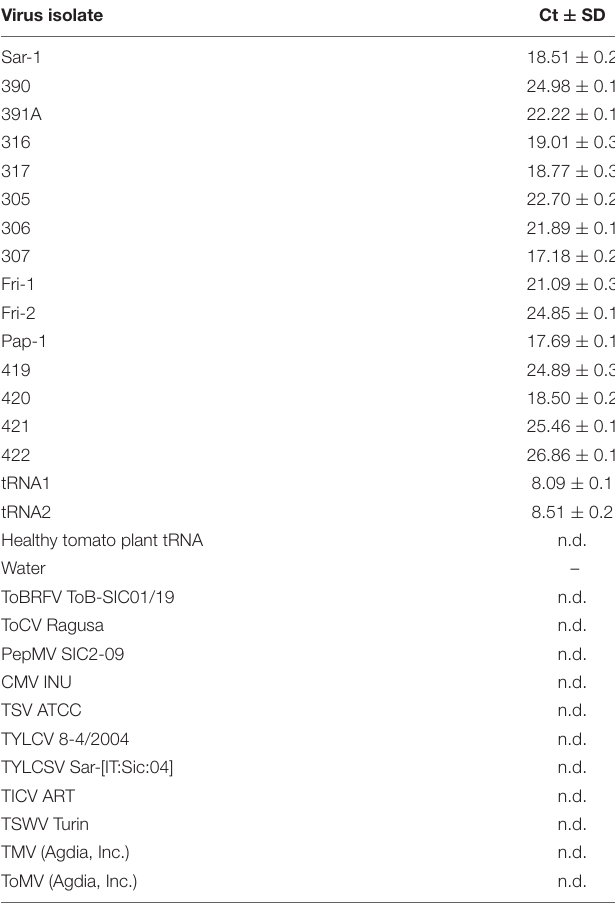
TABLE 3 | Ct values obtained by RT-qPCR assay with TaqMan probe of fifteen PMoV isolates, two RNA transcripts, and other viruses used as outgroups. Virus